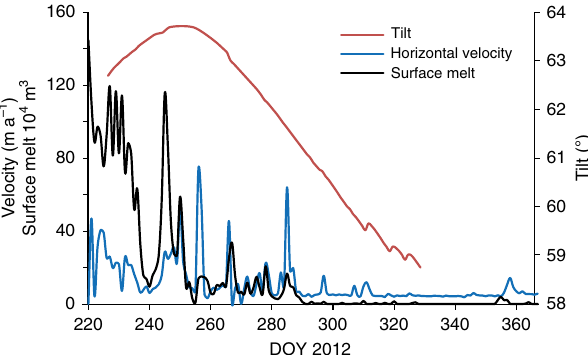
Fig. 4 Graph showing data from 2012 to 2013; daily melt, mean horizontal velocity from the four differential global positioning stations (dGPS) and tilt change from the wireless Glacsweb subglacial